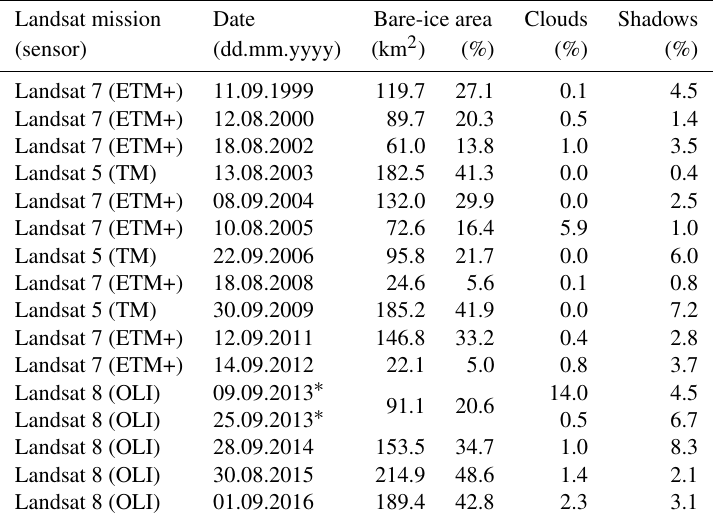
Table 2. Overview of Landsat scenes used. The bare-ice area is given in km 2 and relative to the total study area of 442km 2 . Cloud and shadow coverage are also given relative to the total study area. Landsat mission Date Bare-ice area